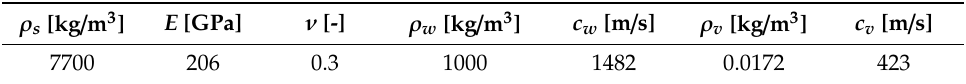
Table 3. Density ( ρ s ), Young’s modulus ( E ) and Poisson’s ratio ( ν ) of the structure; density ( ρ w )